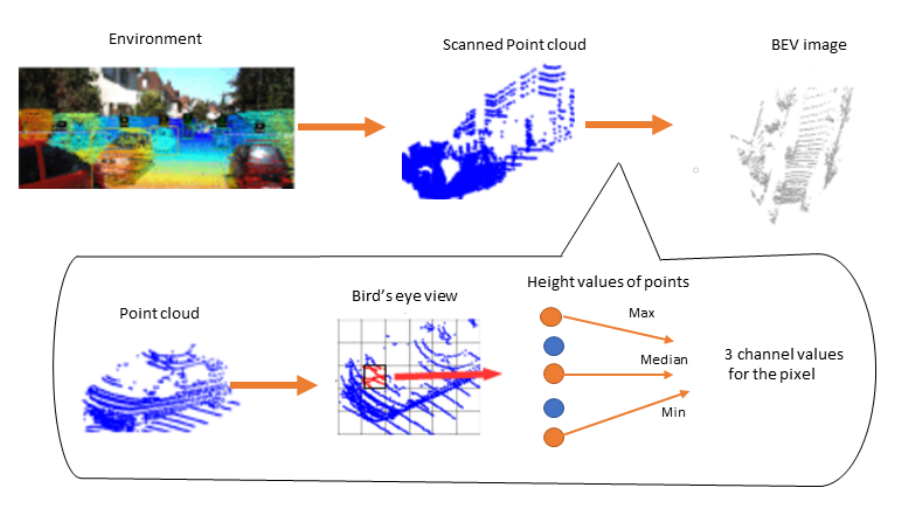
Figure 3. BEV image construction